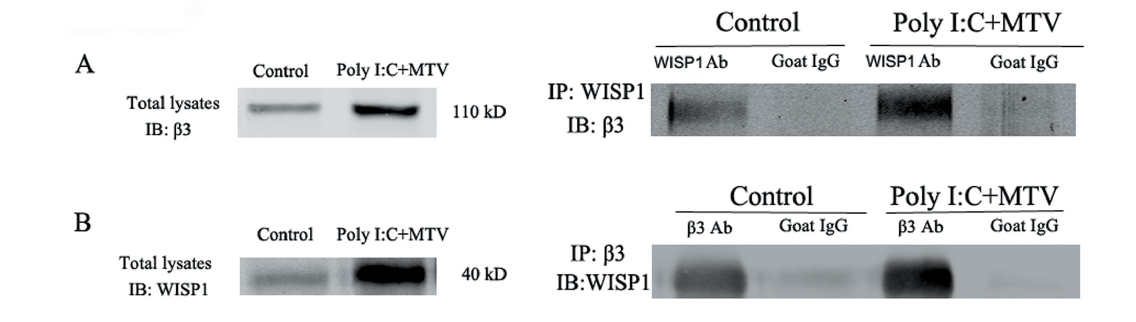
Figure 6. Effects of poly(I:C) + MTV on WISP1/integrin β 3 interaction. Lung tissues were harvested from C57BL/6J mice in the control and poly(I:C) + MTV groups. Total lysates were immunoprecipitated with an anti-WISP1 antibody or an anti- β 3 antibody before immunoblot was performed. (A) Glycosylated form of integrin β 3 (110 kD) was detected with an anti-integrin β 3 antibody (IB: integrin β 3) either in the whole lung tissue lysates (Total Lysates) or after immunoprecipitation with an anti-WISP1 antibody (IP: WISP1). (B) WISP1 was detected with an anti-WISP1 antibody (IB: WISP1) either in the whole lung tissue lysates (Total Lysates) or after immunoprecipitation with an anti- integrin β 3 antibody (IP: integrin β 3). Antibody species matched serum (Goat IgG) was used as a negative control for coprecipitation experiments. WISP1 and integrin β 3 interact was enhanced in the poly(I:C) + MTV group as compared with the control group.